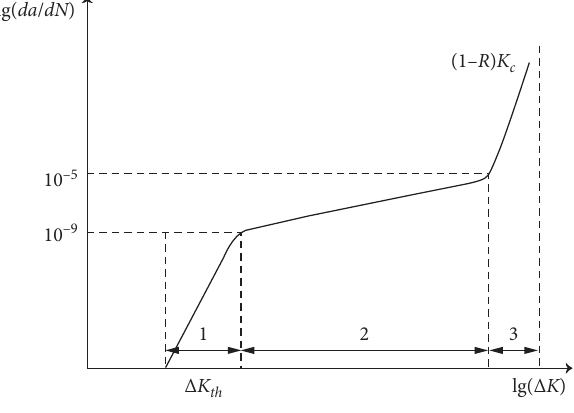
Figure 1: ( d a /d N ) − Δ K